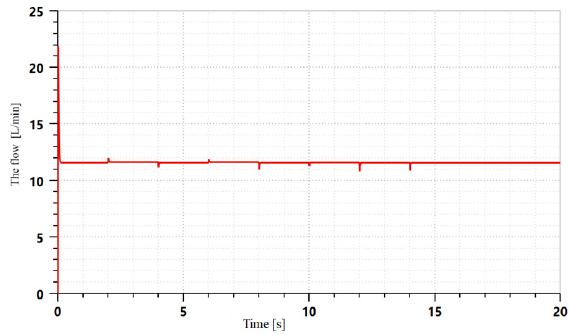
Figure 15. Viscous damping coefficient of 100 N/(m·s).